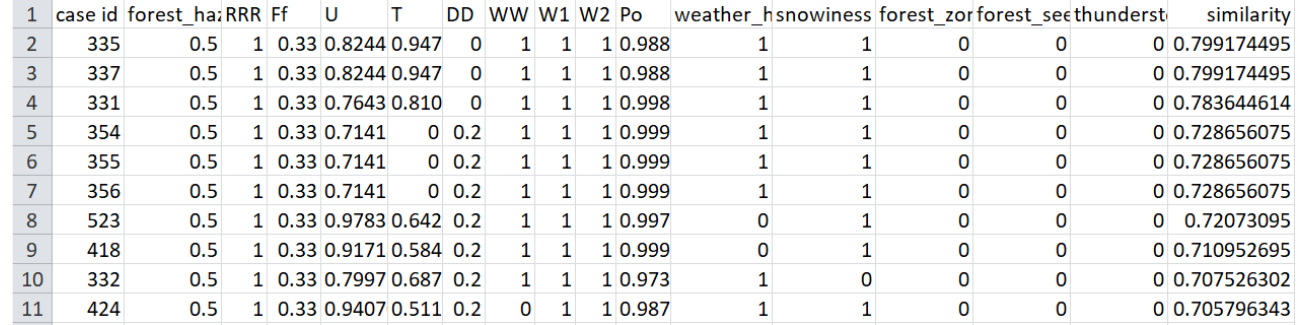
Figure 10. A fragment of the CSV file with the results of calculating similarity for a separate quarter. Each row corresponds to a specific case and similarities of its properties; the last column presents a total (or global) similarity.